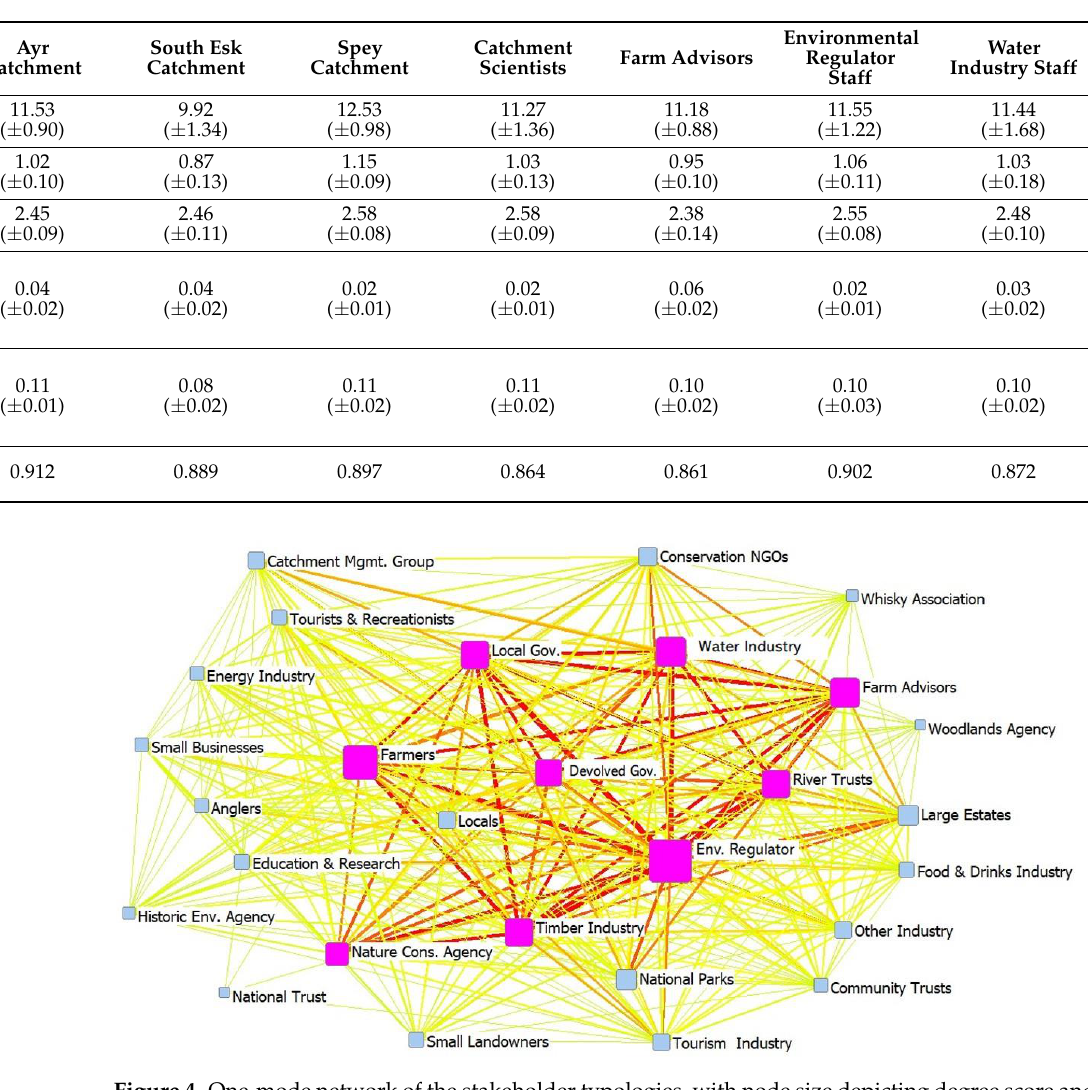
the Ayr catchment, but not the Devolved Government and Farmer nodes, unlike the core